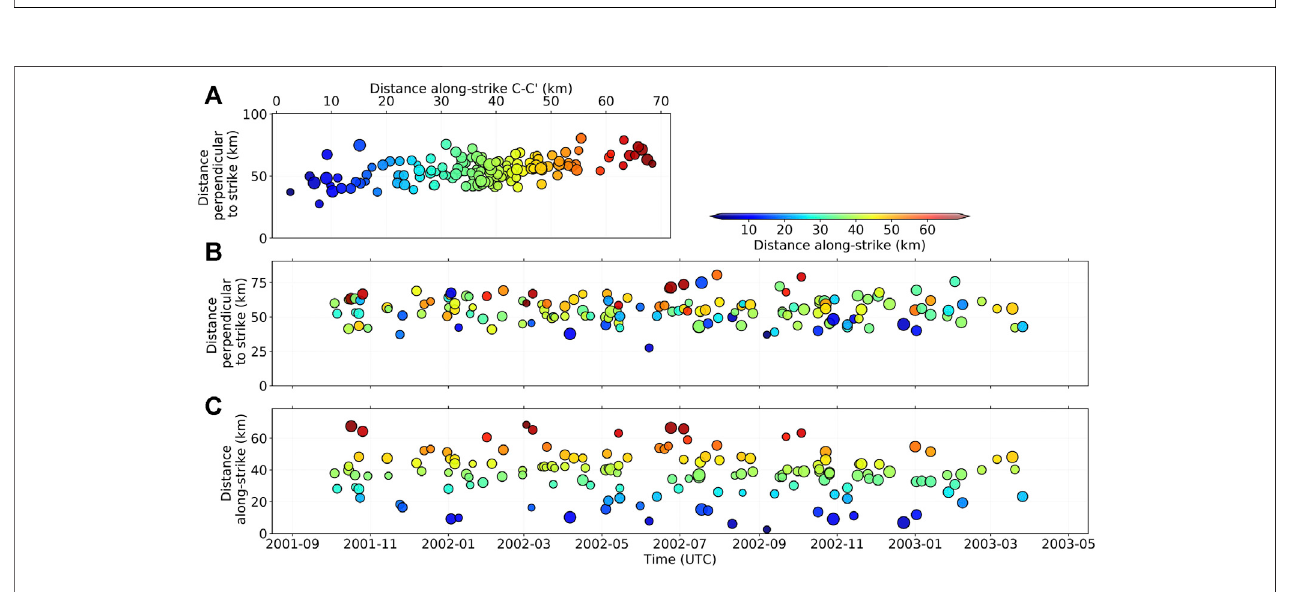
FIGURE 9 | Same as Figure 8 but for cross-sections C – C ′ and D – D ’ .